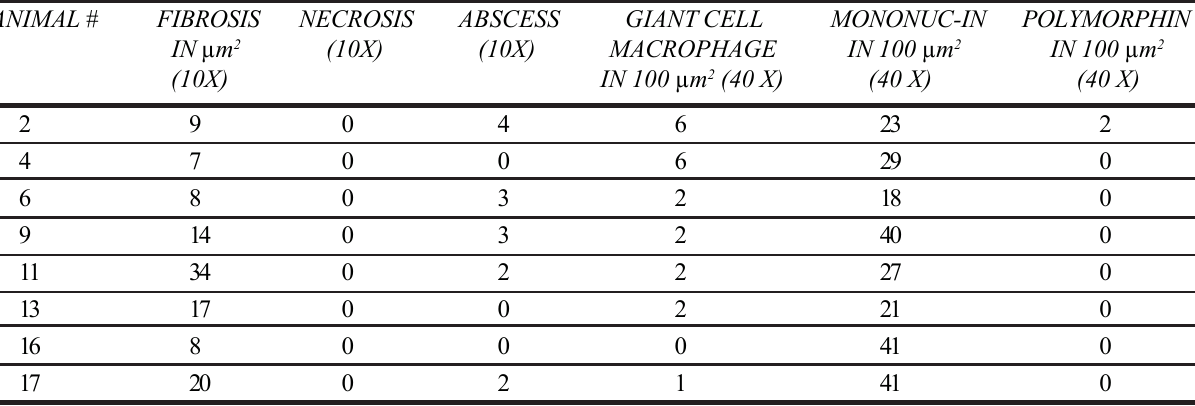
TABLE 5 - Mean of measurement and counting of microscopic findings of three cuts, in each animal of cohort E-B, under 10 and 40x magnification